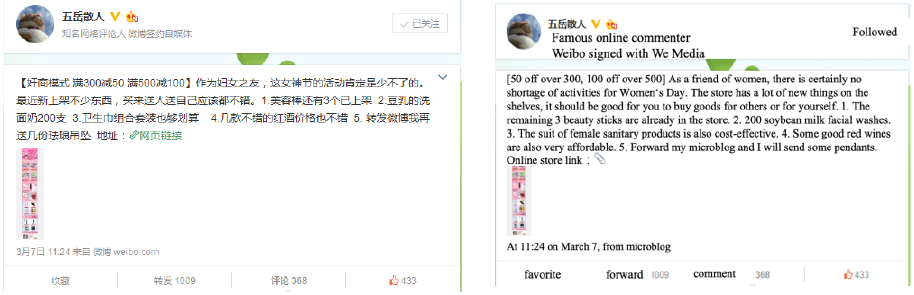
Figure 8. An instance of the special users we study. In this experiment, five different promotional microblogs are selected and analyzed, and detailed information about them is shown in Table 4. Table 4. Detailed information on five different promotional microblogs.